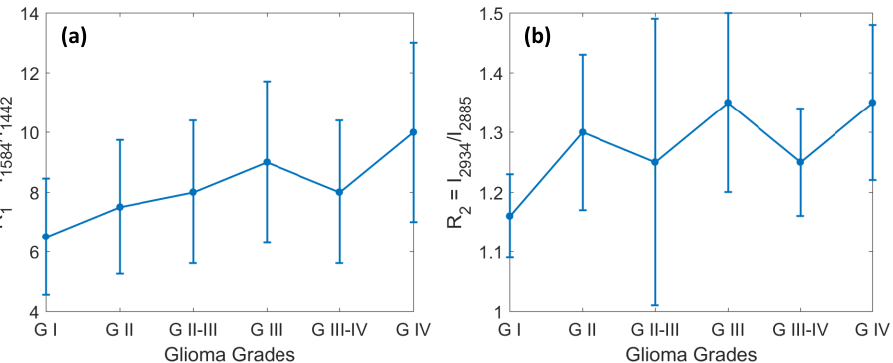
Figure 3. Average VRR spectral data plots: the ratios of ( a ) R1 = I 1584 /I 1442 and ( b ) R2 = I 2934 /I 2885 from glioma tissues with increasing malignancy. G I, glioma grade 1; G II, glioma grade 2; G II-III, glioma grade 2–3; G III, glioma grade 3; G III-IV, glioma grade 3–4; and G IV, glioma grade